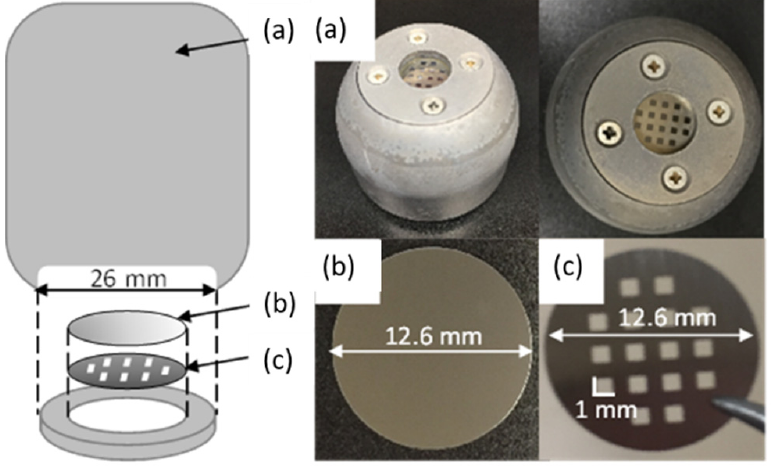
Figure 2. Structure of target electrode. ( a ) Target electrode, ( b ) silicon wafer, and ( c ) stainless steel mask.